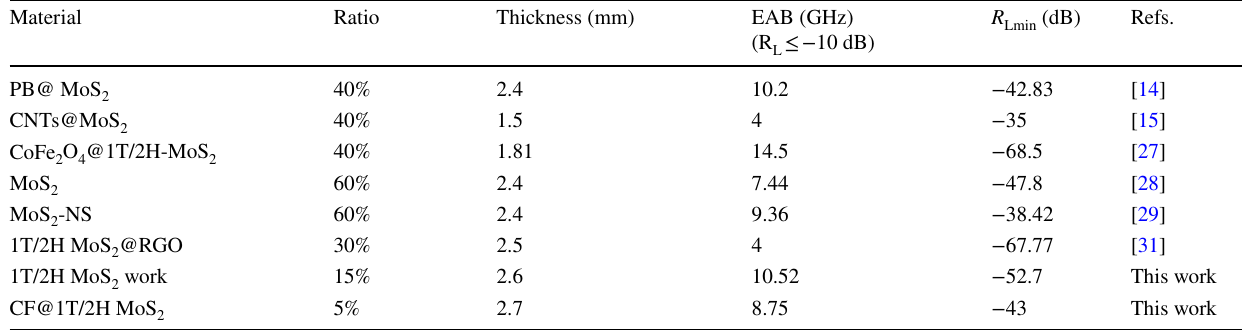
Table 1 Summary of MoS 2 -based EMW absorbers